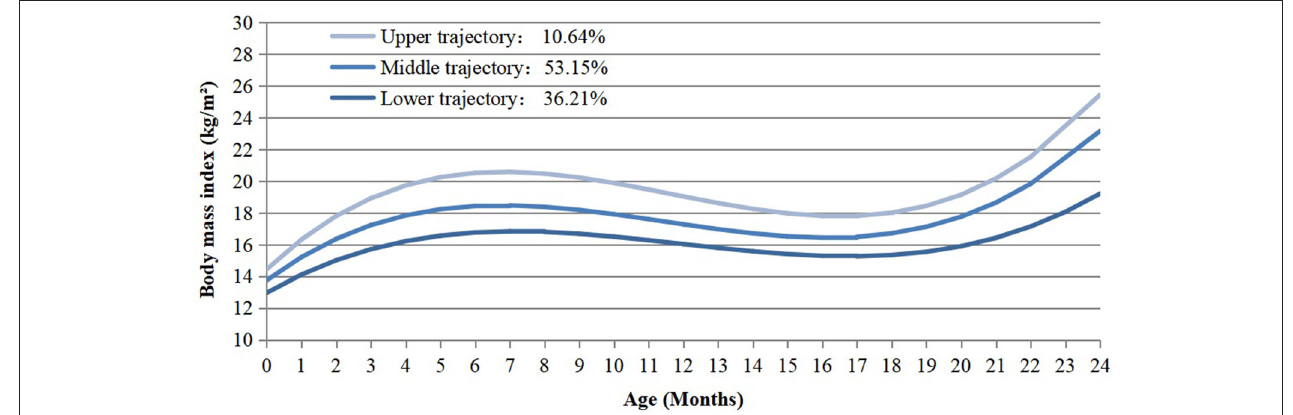
FIGURE 2 | BMI trajectories from birth to 2 years old identified from the LCGMM.